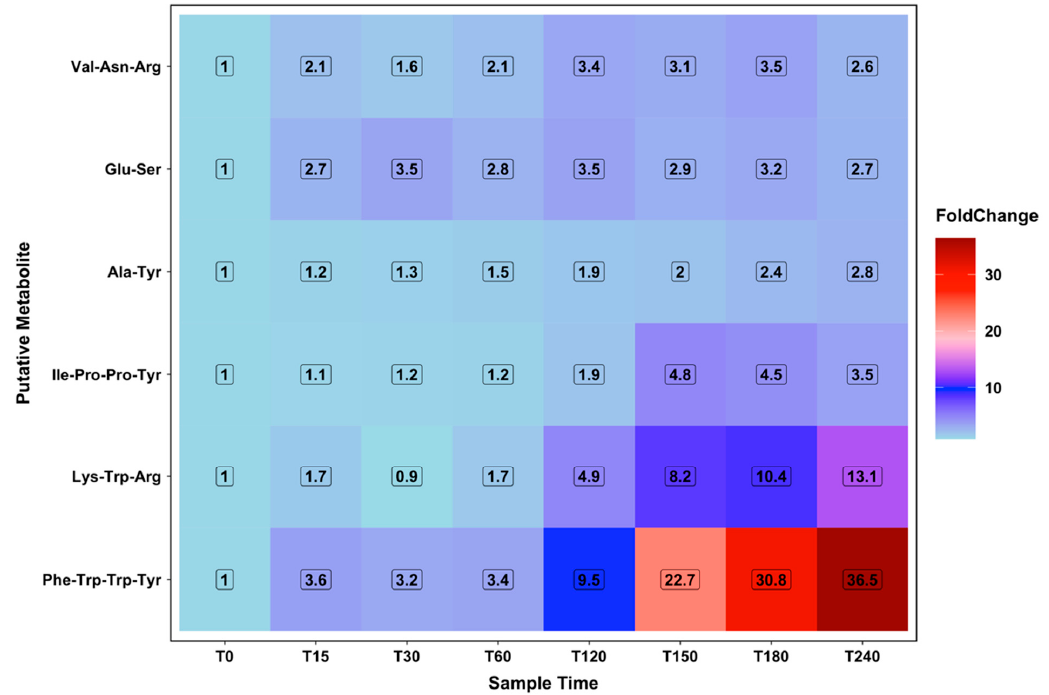
Figure 5. Metabolites putatively identified as peptides. Values coloured from blue to red as fold change increases.